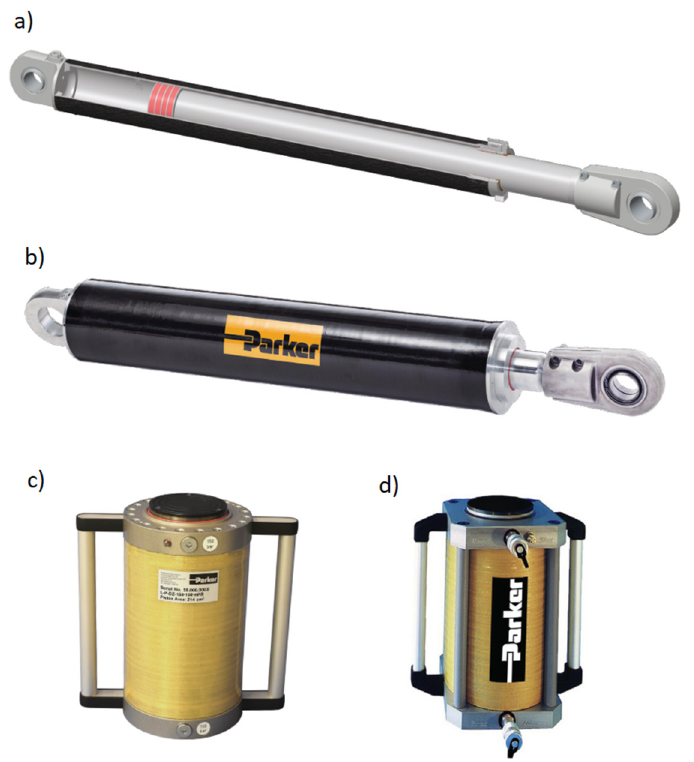
Figure 15. Examples of Parker Lightraulics actuator designs: ( a ) a cross-section showing the cylinder structure, ( b ) a cylinder with a high stroke-to-diameter ratio, ( c ) a cylinder with a low stroke-to- diameter ratio, and ( d ) a cylinder with a low stroke-to-diameter ratio with tie-rods [55].